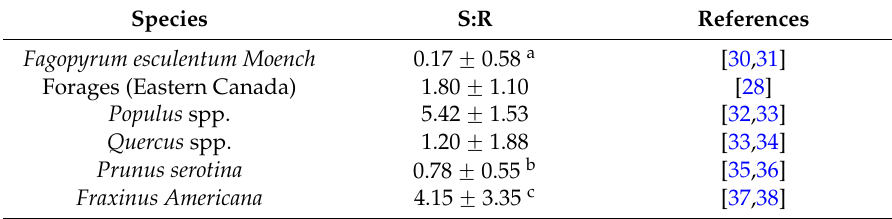
Table 3. Shoot:Root (S:R) values used for C budget calculations for crop and tree species grown in tree-based intercropping systems at St. Paulin and St. Edouard, southern Quebec,